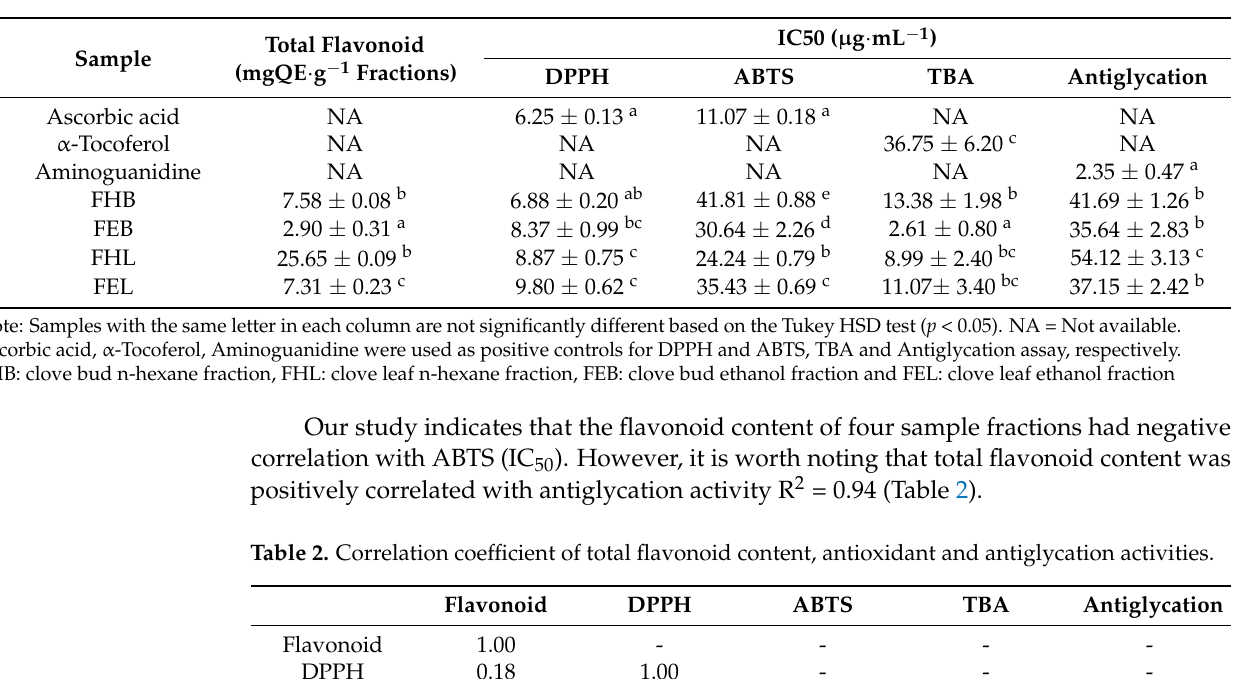
Table 1. Antioxidant activities and antiglycation activity of n- hexane and ethanol fractions from clove buds and leaves, in vitro.